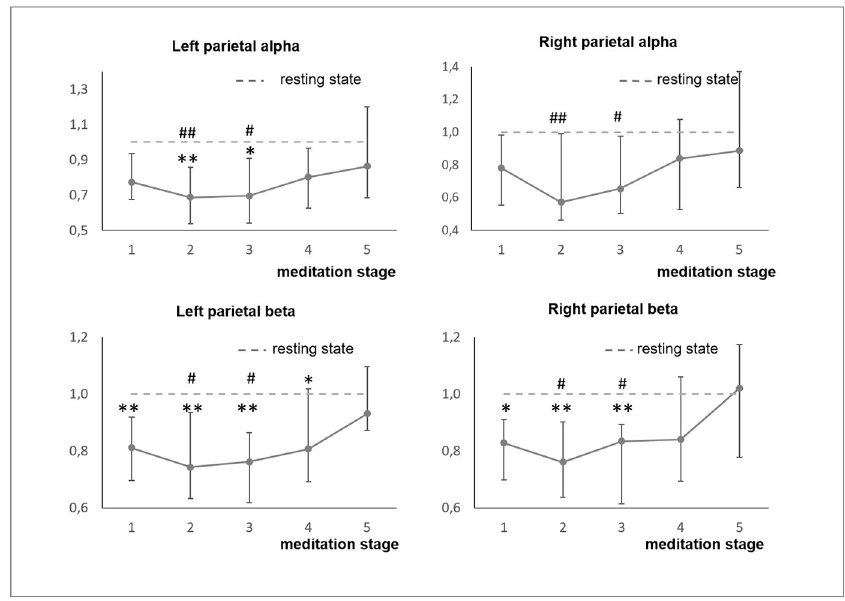
Fig 4. Changes of EEG-derived indices in both groups together. Changes of EEG-derived indices that had the same dynamics in the both groups according to the curve comparison test were analyzed using one-way ANOVA test. The obtained p-values were corrected for multiple comparisons using the FDR B-H procedure. Those that had a significant effect of “meditation stage” factor were analyzed by the post-hoc Tuckey test. Both groups combined (n = 28) were analyzed. Data presented as Median ± IQR. � , �� —significant difference from resting state (p < 0.05, p < 0.01). #, ##- significant difference from the 5 th meditation stage (p < 0.05, p <